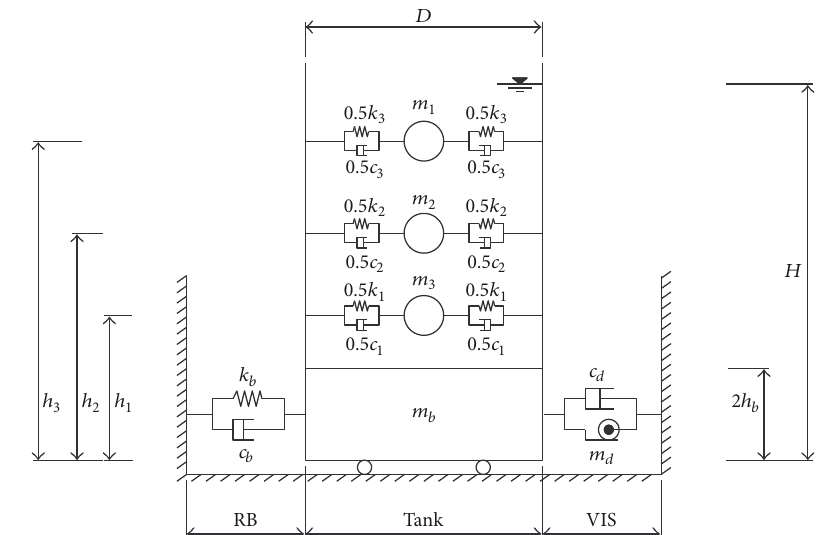
Figure 1: Simplified model of the controlled rigid tank with the inerter system.